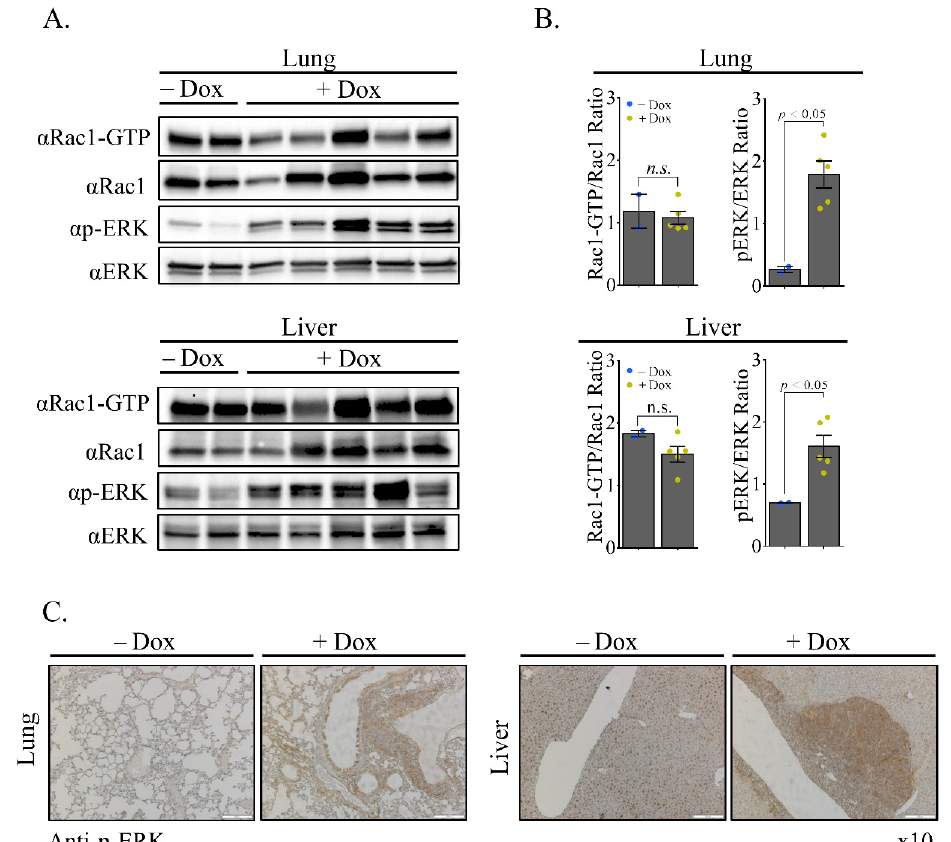
Figure 5. Activation of ERK in Lymphomas from Rosa Vav1 mice. Analysis of Rac1 activation in the lung and ERK activation in the lung and liver of Rosa Vav1 mice either treated (+Dox) or non ‐ treated ( − Dox), 12 months post transgene induction was performed. ( A ) Protein lysates from _Rosa Vav1 transgenic mice were evaluated Rac1 ‐ GTP activation (upper panel; lung and liver tissues) and ERK phosphorylation (lower panels; lung and liver respectively) by using anti ‐ Rac1 ‐ GTP, anti ‐ Rac1, anti ‐ pERK and anti ‐ ERK Abs in western blotting. ( B ) The relative ratios of Rac1 ‐ GTP/Rac1 and pERK/ERK were calculated from the blots shown in A. The mean intensity of the western blots was quantified using ImageJ 1.49 V software. Numbers of mice used: non ‐ treated ( − Dox; n = 2); treated (+Dox; n = 5). SEM and significance between the treated (+Dox) and the non ‐ treated ( − Dox) analyzed by t ‐ test are indicated. ( C ) Sections of lung (left) and liver (right) from indicated mice were stained with anti ‐ pERK antibodies. Representative pictures are shown. Magnification at ×10.